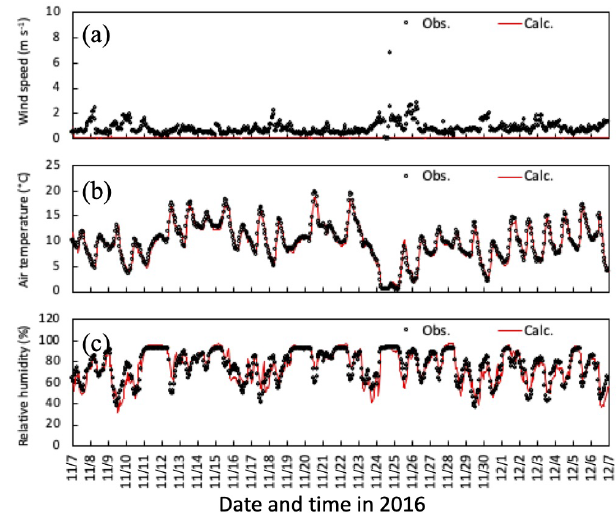
Figure 5. Temporal changes in observed and simulated (a) horizon- tal wind speed, (b) air temperature, and (c) relative humidity at 6m height from 7 November to 6 December 2016. Please note that the date is given on the x axis in the month/day format.